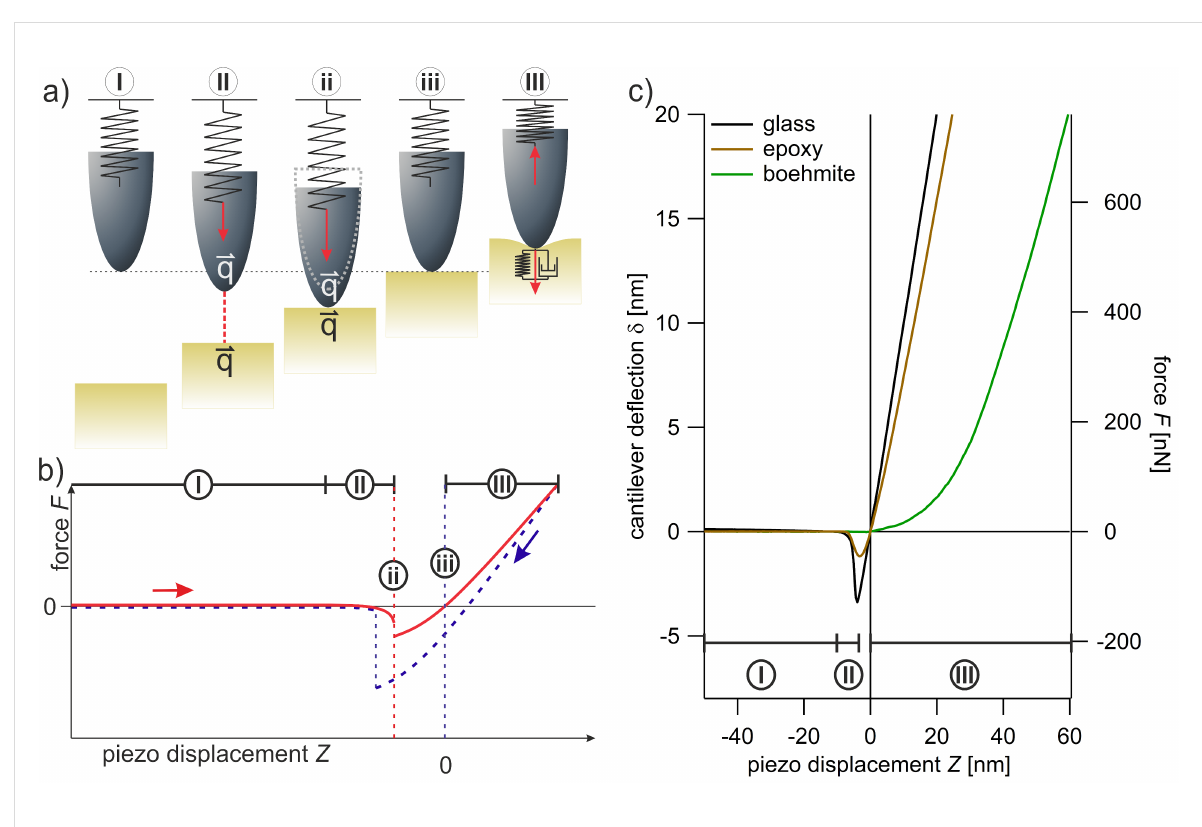
Figure 1: (a) Representation of tip–sample interactions. (b) Schematic drawing of a FDC. (c) FDCs (approach, averaged from at least 50 single curves) acquired from bulk materials: boehmite (green), epoxy (brown), and glass (black, for comparison). With (I) zero line, (II) regime of attractive forces, (ii) JTC, (iii) contact, and (III) contact line. The measurements were performed with the tip A.